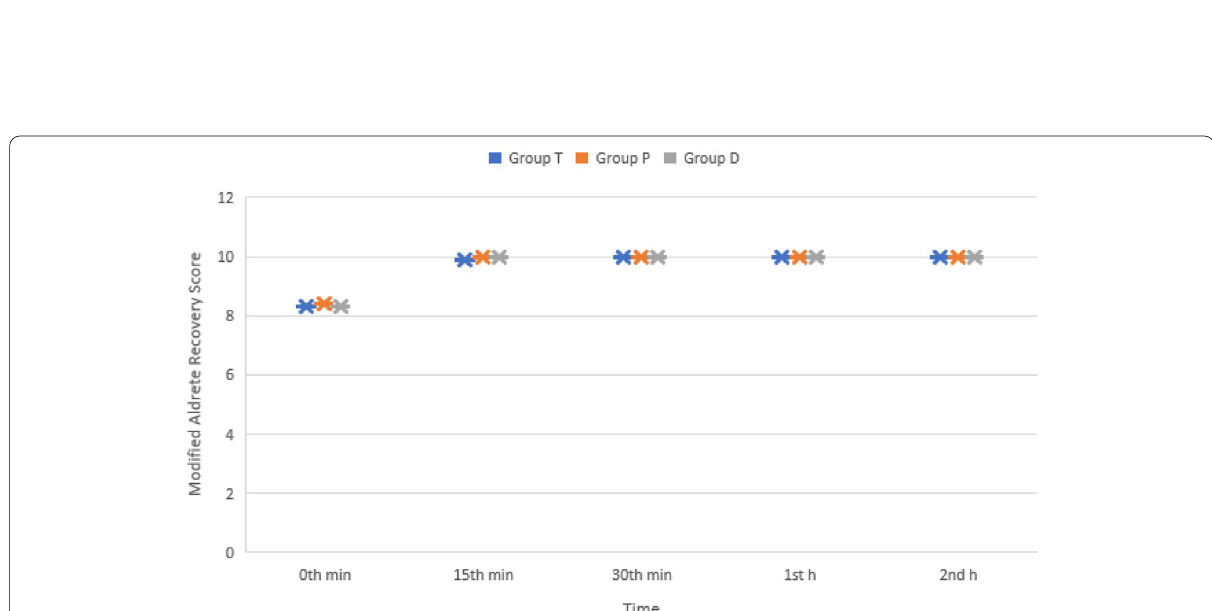
Fig. 4 Graphical presentation of the Modified Aldrete Recovery scores mean values of the groups. Data are mean (SD), T, tramadol group; P, paracetamol group; D, dexketoprofen trometamol group; min, minute; h,